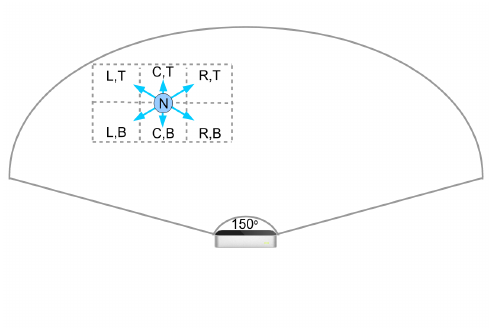
Fig. 9: Possible movement directions of the left hand: L,T (left, top), L,B (left, bottom), C,T (center,top), C,B (center,bottom), R,T (right,top), R,B